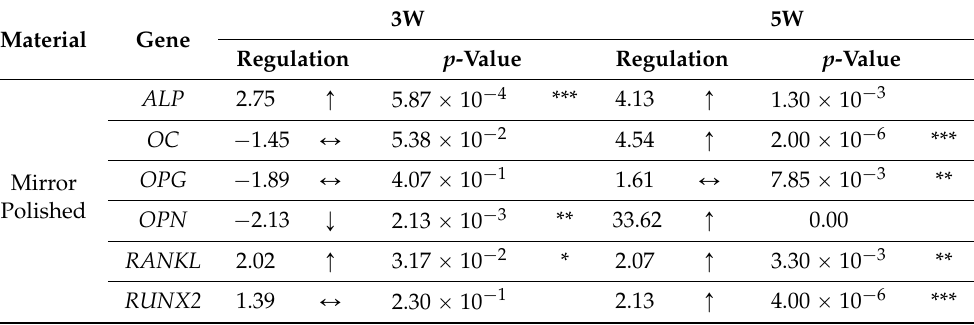
Table 5. The influence of POPE on HDBC gene expression was determined via real-time PCR analyses by normalizing each POPE-coated material to the corresponding material without phospholipids ( ∆∆ C t ) after three weeks (3 W) and five weeks (5 W). Regulation: fold expression values are compared to regulation threshold ( Ò up regulation, Ó down regulation, and Ø no change). p -values given